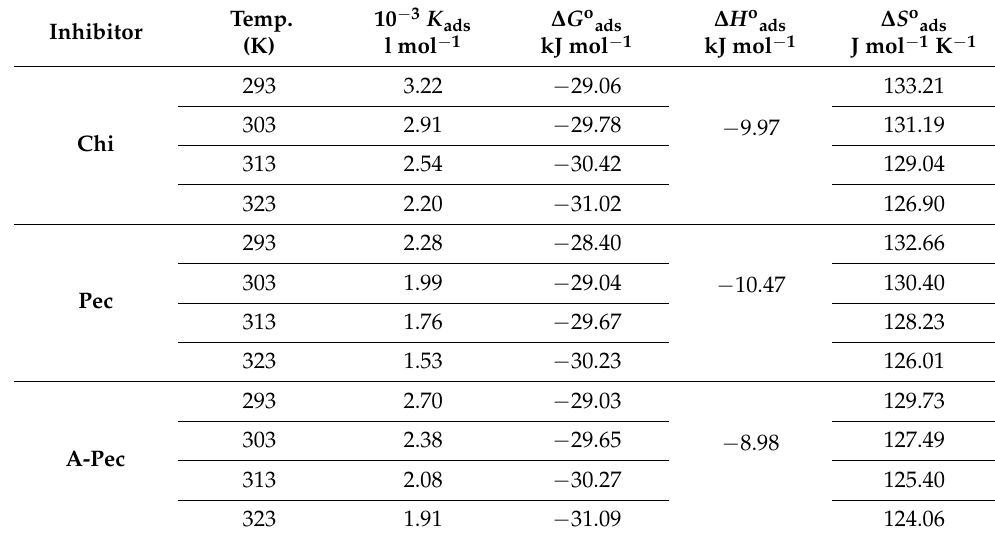
Figure 13. Langmuir adsorption isotherms for the tested carbohydrate polymers: ( a ) Chi, ( b ) Pec, and ( c ) A-Pec adsorbed on mild-steel surface in 0.5 M HCl solution at different temperatures. Table 5. Thermodynamic parameters and K ads for mild-steel corrosion in 0.5 M HCl solution in the absence and presence of the examined carbohydrate polymers at diverse temperatures. Temp. Inhibitor